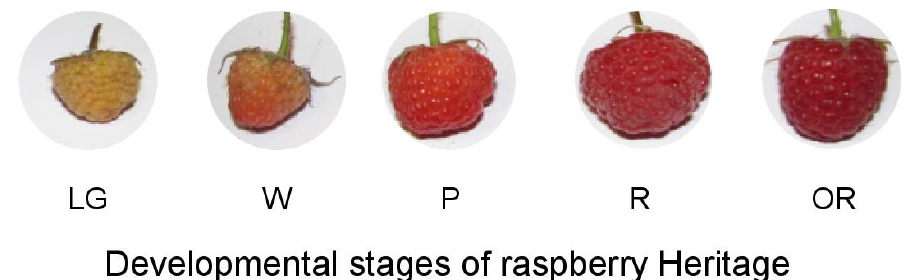
Figure 1. Developmental stages of raspberry ( Rubus idaeus ‘Heritage’) fruit. The fruit was harvested and sorted by size and color as follows: large green (LG), white (W), pink (P), red (R) and overripe (OR)